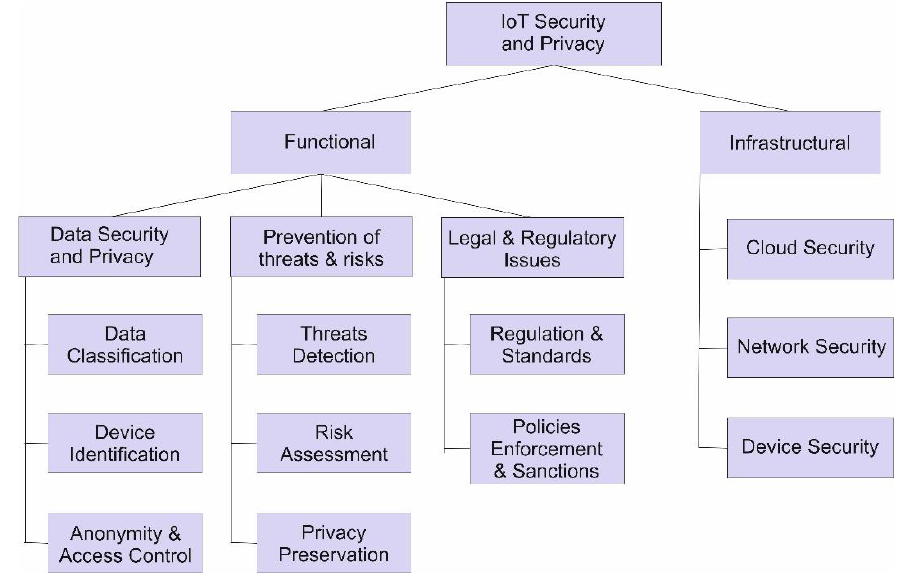
Figure 3. Taxonomy of IoT Security and